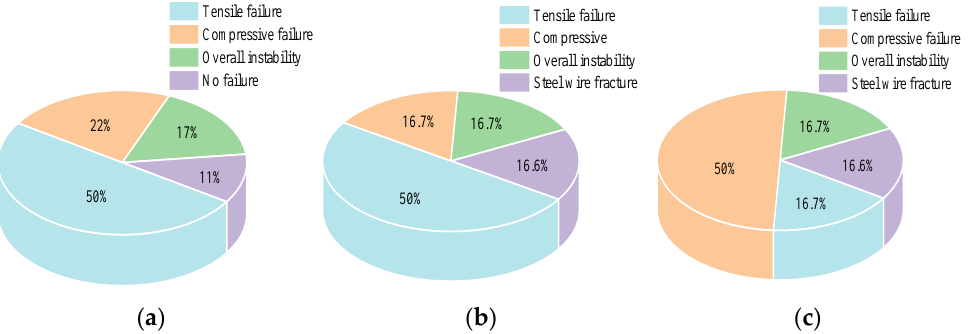
Figure 18. The failure mode of continuous beam. ( a ) short-term beams; ( b ) long-term beams; ( c ) regulated